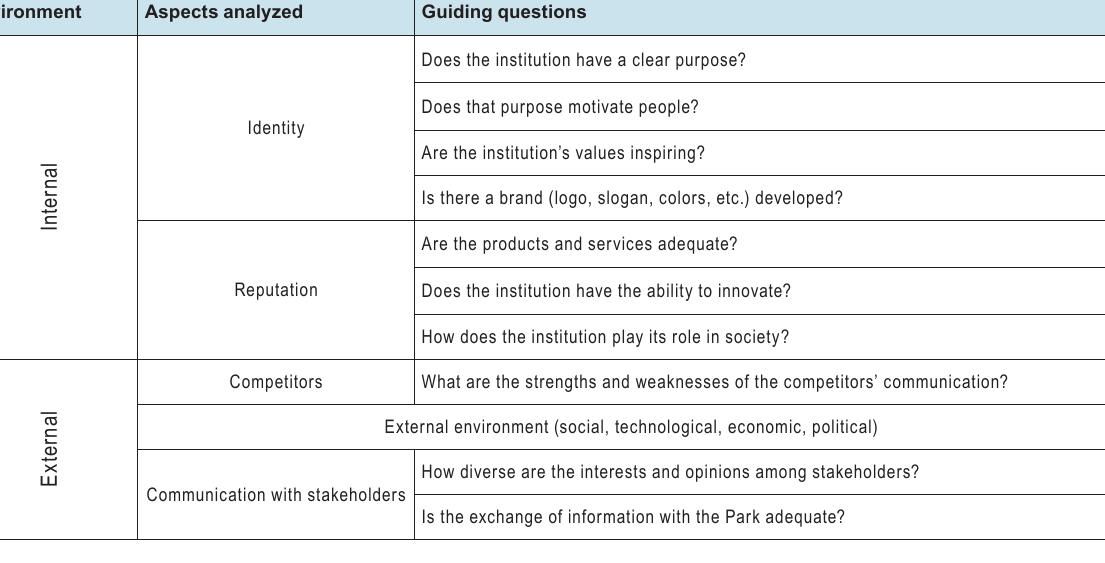
TABLE 1. SWOT analysis structure applied to the Varvite Geological Park’s communication. Environment